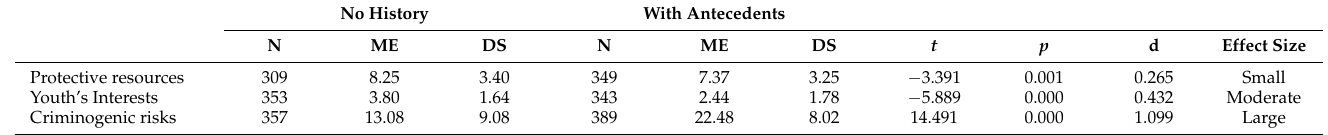
Table 5. Discriminant validity. Comparison of groups according to retrospective criminal recidivism.